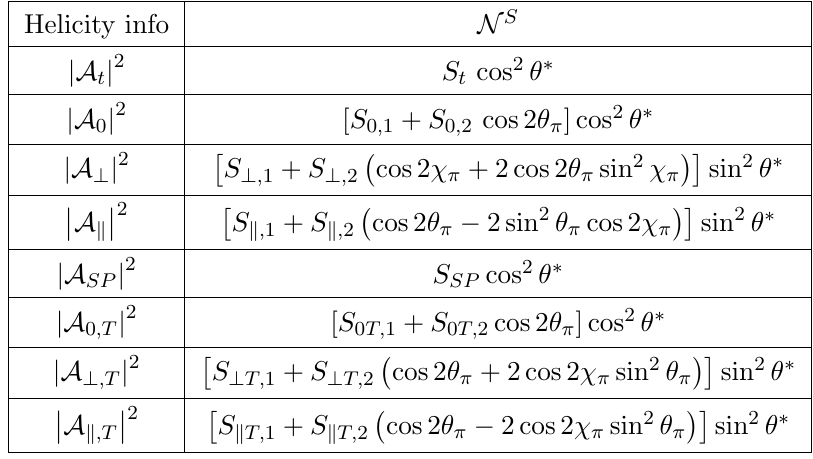
Table 5 . Contributions to the N S jA i j 2 pieces of eq. (2.15). The coe(cid:14)cients S i depend on the i kinematic parameters q 2 and E (cid:25) , and are listed in eq.